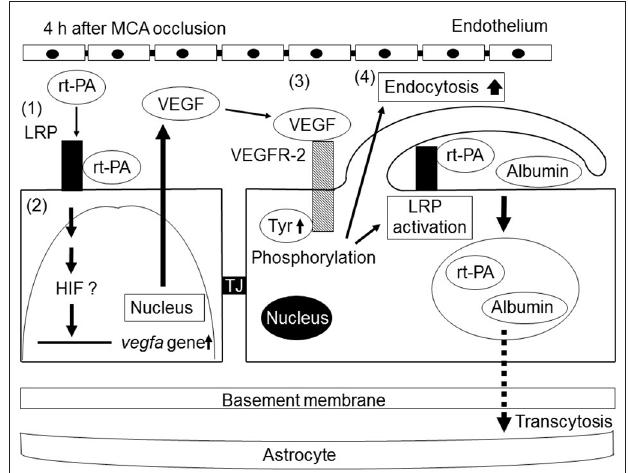
FIGURE 2 | Schematic of the mechanisms of the increase in BBB permeability by recombinant tissue-type plasminogen activator (rt-PA) treatment after ischemic stroke. rt-PA activates the low-density lipoprotein receptor-related protein (LRP), which is upregulated in endothelial cells (ECs) by ischemic stress (1). The activation of LRP induces the transcriptional upregulation of VEGF. Secreted VEGF binds to VEGFR-2 on the surface of ECs through an autocrine mechanism and induces its phosphorylation (3). The activation of VEGFR-2 leads to an increase in endocytosis and to the activation of LRP, resulting in enhanced BBB permeability by endocytosis and subsequent transcellular transport of proteins into cerebroparenchyma (4). Tyr,